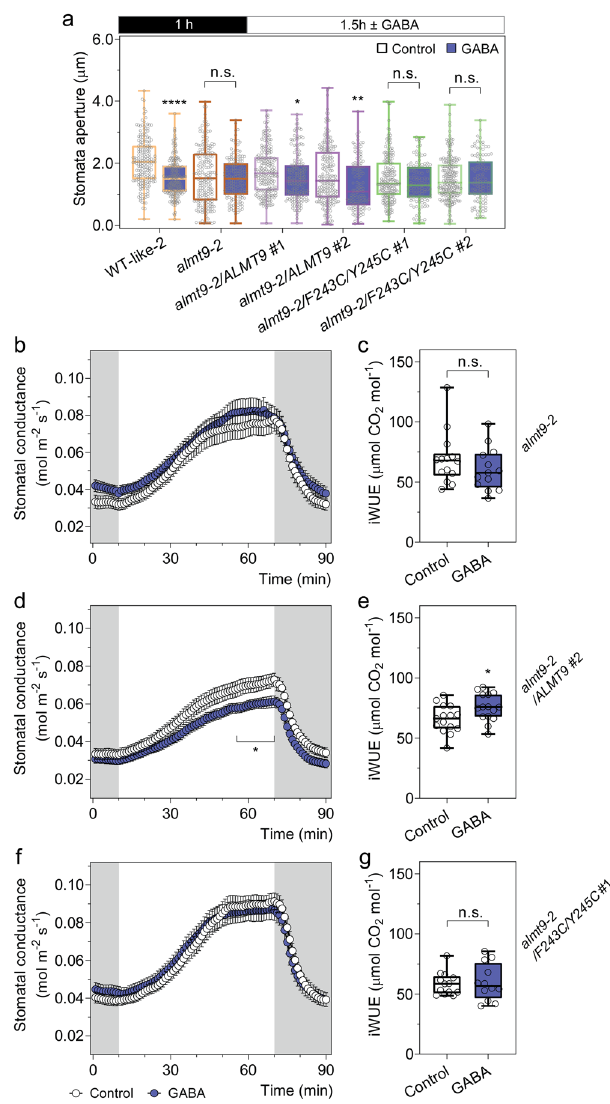
expression in almt9-2 complementation lines and the mutations (in ALMT9 F243C/Y245C ) did not alter the membrane localisation with both versions of the ALMT9 protein being clearly present on the tonoplast (Supplementary Fig. 16). Further, we found that similar to almt9 lines, almt9-2 expressing ALMT9 F243C/Y245C was insensitive to and detached leaves, for stomatal opening and stomatal conductance, respectively; this contrasts the GABA sensitivity of wild-type plants and plants expressing native ALMT9 in the almt9-2 background (Figs. 2c and 8a, b, d, f; Supplementary Fig. 17a, b, d, e, g, h). Furthermore, instantaneous iWUE/WUE of almt9-2 was improved by native ALMT9 complementation, but not ALMT9 F243C/Y245C (Fig. 8c, e, g; Supplementary Fig. 17c, f, i). Steady-state stomatal conductance and aperture of ALMT9 F243C/Y245C lines were also signi fi cantly greater than that of wild-type and almt9 lines and were insigni fi cant from gad2-1 under standard conditions (Fig. 9;